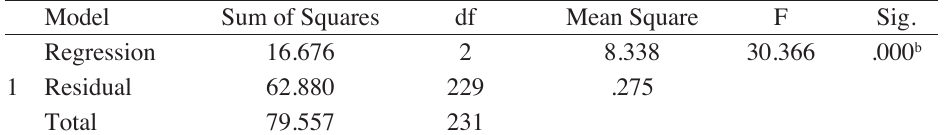
Table 4: ANOVA (Reward and Job Satisfaction) Model Sum of Squares df Mean Square F Sig. Regression 16.676 2 8.338 .000 b Residual 62.880 229 .275 Total 79.557